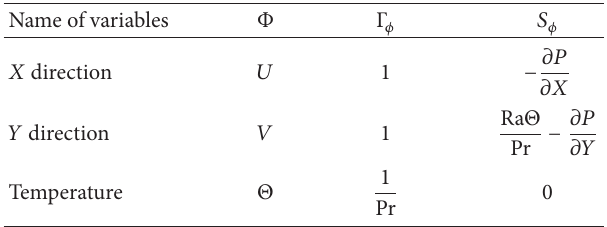
Table 2: Parameters of equations for MAC of natural convection